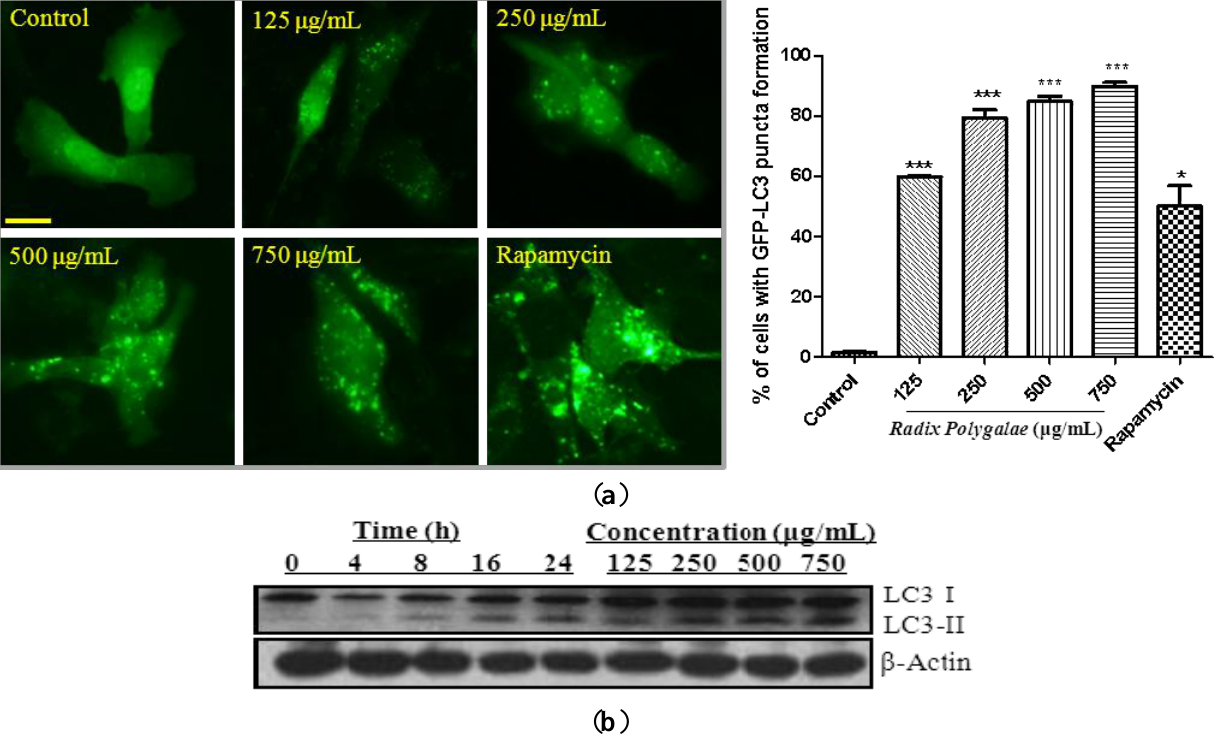
Figure 1. Radix Polygalae ethanol extracts induce autophagy. ( a ) Representative images showing the formation of GFP-LC3 puncta in PC-12 cells after treatment of Radix Polygalae ethanol extracts at the indicated concentrations for 24 h. Rapymycin (0.3 μM) was used as a positive control. Right: bar chart represents the percentage of cells with GFP-LC3 puncta formation. Magnification, ×40; ( b ) PC-12 cells were treated with Radix Polygalae ethanol extract for the indicated time and concentrations. Cell lysates were analyzed by western blot for LC3 conversion (LC3-I, 18 kDa; LC3-II, 16 kDa) and β-actin,